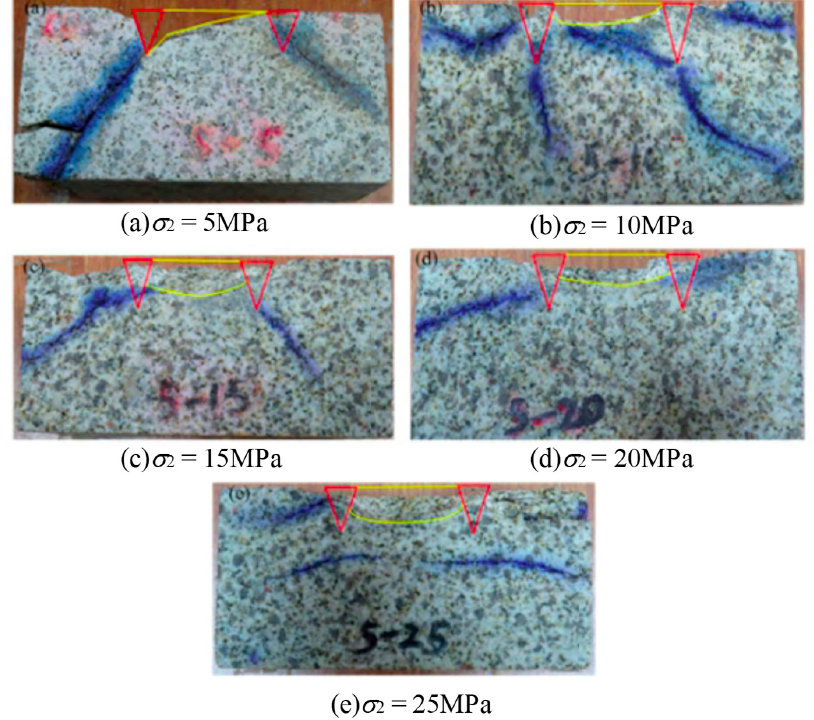
Figure 8. Crack development in the cross section with increase of σ 2 , while σ 1 is 5